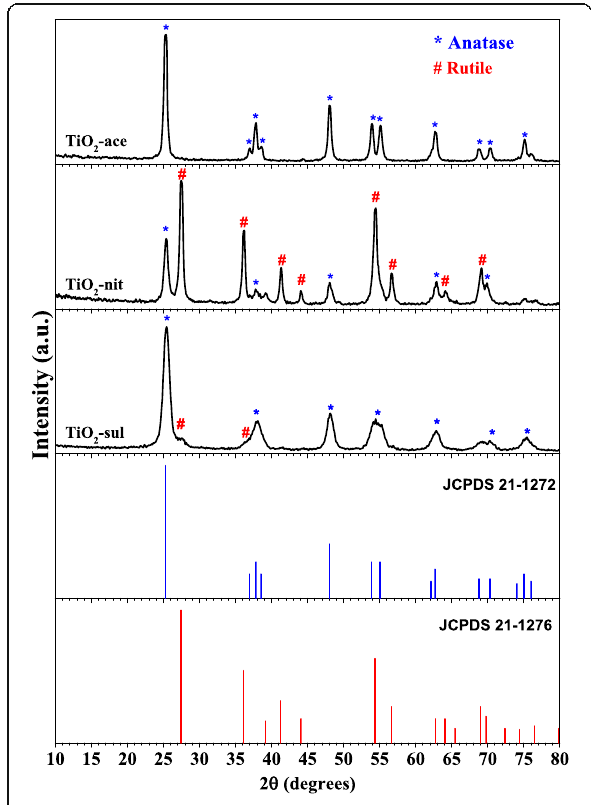
Fig. 1 Powder XRD patterns of the calcined TiO 2 samples (reprinted with permission from [29]. Copyright @ 2017 Elsevier)